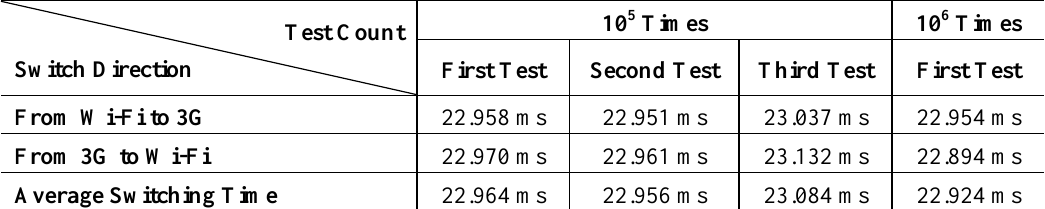
Table 3. Average switching time between Wi-Fi and 3G